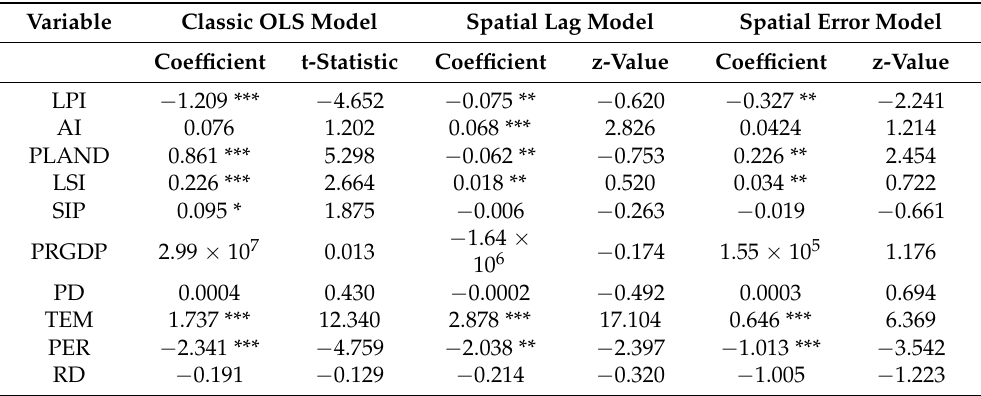
Table 3. Global regression